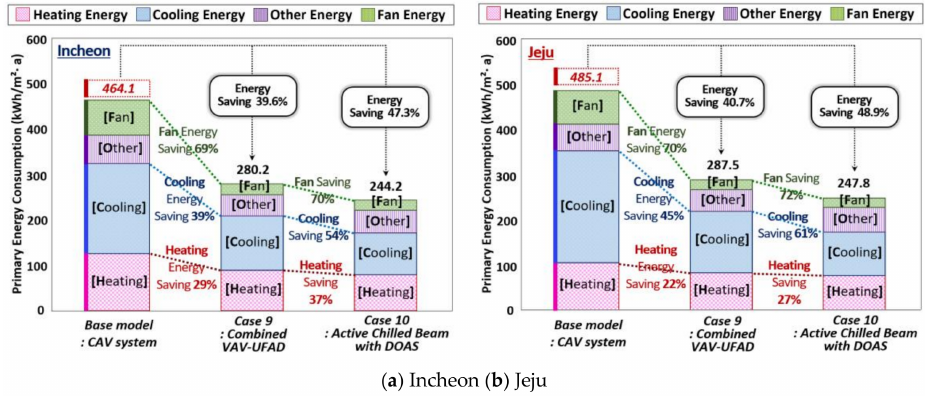
Figure 15. Primary energy consumptions and energy saving potential (%) of Case 9 and Case